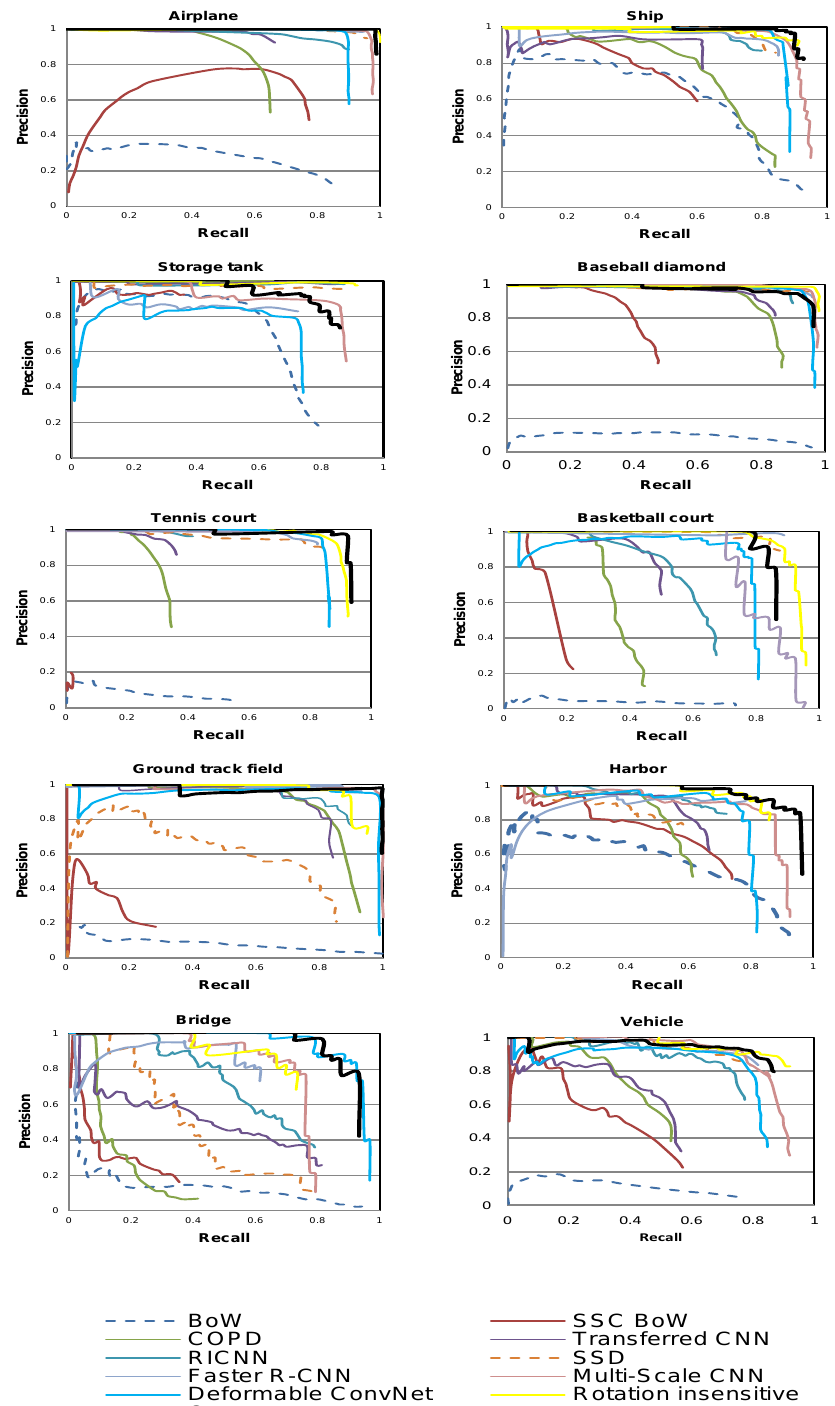
Figure 7. Comparison of area under precision-recall curve with different state-of-the-art